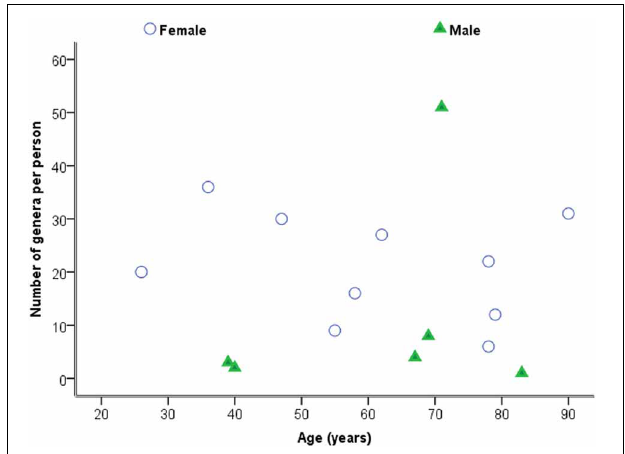
FIGURE 2 | Plot of number of genera against age by sex.